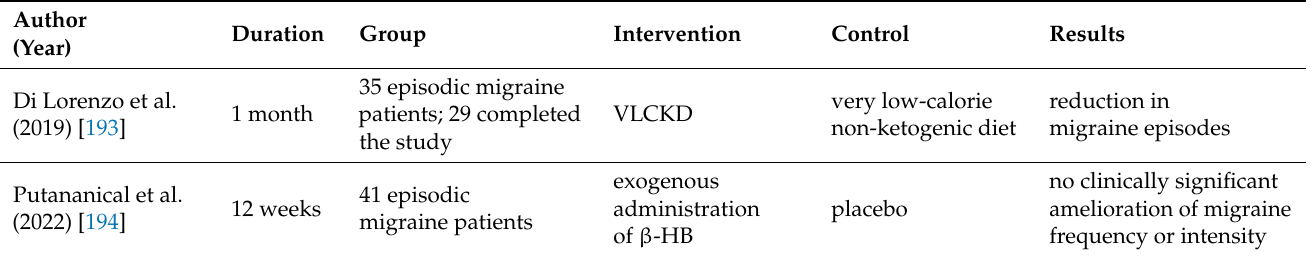
Table 2. Results of a clinical trial and a randomised controlled trial conducted in the last 7 years